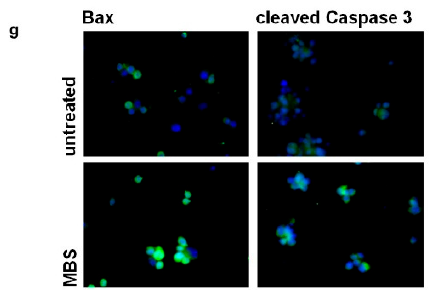
Figure 2. IBS and MBS induce apoptotic death of leukemia cells. Apoptosis of untreated and IBS- and MBS-treated BCL1 and JVM-13 cells for 24 h ( a ) evaluated by flow cytometry using Annexin V (FITC) and PI double staining. ( b ) Representative dot plots illustrate populations of viable (AnnV − PI-), early apoptotic (Ann V+ PI − ), late apoptotic (AnnV+ PI+), and necrotic (AnnV − PI+) BCL1 cells treated with IBS or MBS. Percentage of Mcl-1 and Noxa positive ( c ) JVM-13 and ( e ) BCL1 cells evaluated by flow cytometry. mRNA expression of Bax and Bcl -2 in ( d ) JVM-13 and Bax and ( f ) caspase-3 expression in BCL1 cells treated by IBS and MBS quantified by qRT-PCR. ( g ) Immunofluorescence staining for Bax (green) and cleaved caspase-3 (green) together with DNA staining with DAPI (blue) in BCL1 cells incubated with MBS (2 μ g/mL) for 24 h, as well as in untreated cells (magnification × 200). The data are presented as means + SDs of a three independent experiment. * p < 0.05, ** p < 0.01, *** p < 0.001 indicate differences between treated and untreated cells.